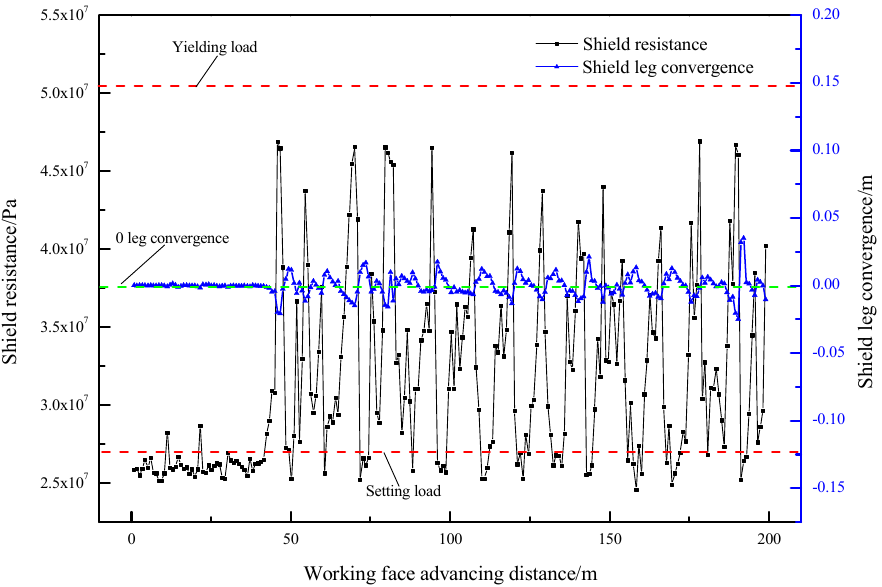
Figure 5. Changes of shield resistance and leg convergence under 2.5 m mining height.